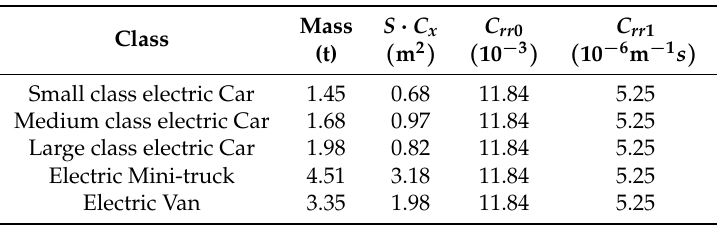
Table 7. Electrical vehicle data.